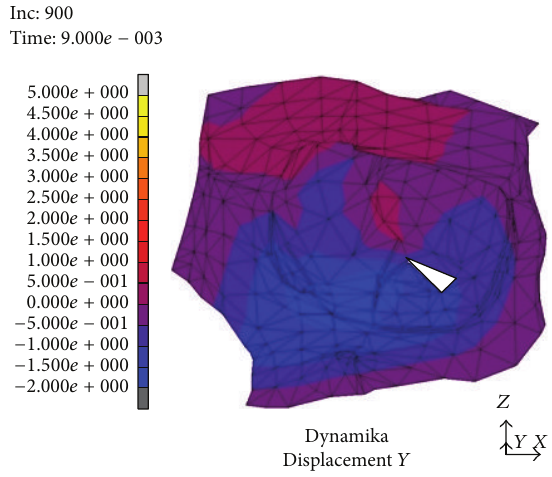
Figure 4: Dislocation after 𝑡 = 9 ⋅ 10 −3 s from the strike.